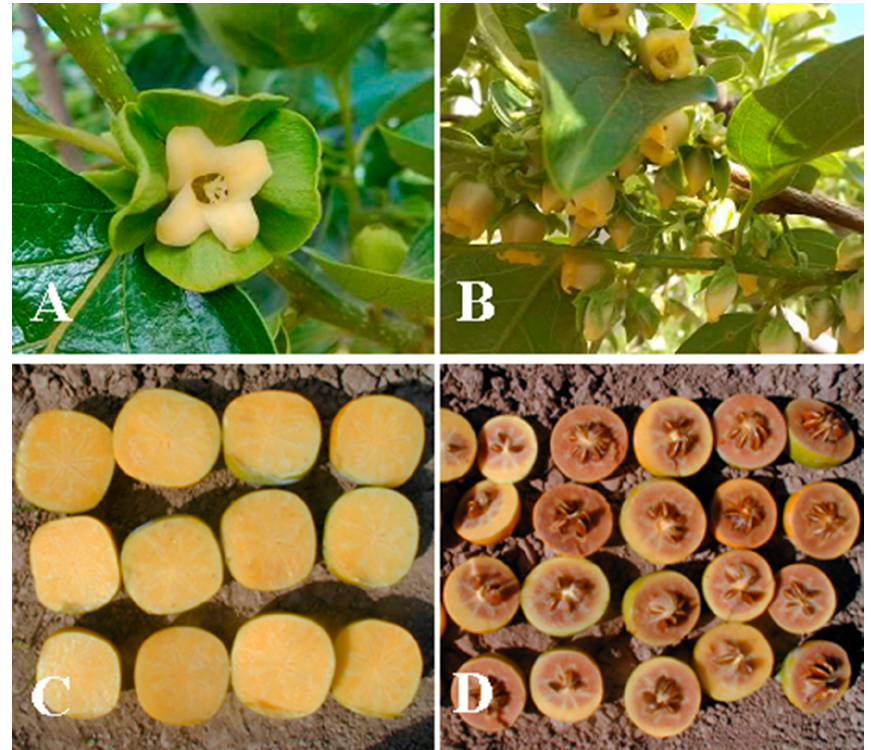
Figure 1. Phenotypes of the traits selected. ( A , B ) flowers from the variety ‘Cal Fuyu’, female and male respectively and ( C , D ) results of pollination on astringent fruits from ‘Rojo Brillante’ a pollination variant astringent (PVA) variety: ( C ) parthenocarpic non-pollinated fruits and ( D ) pollinated fruits in which presence of seeds resulted in no marketable